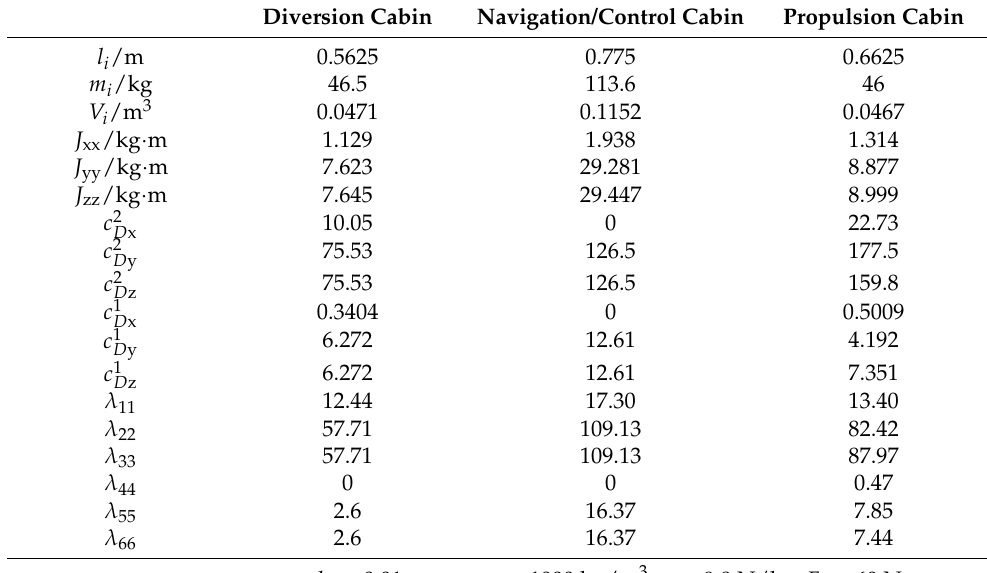
Table A1. The Parameters of the MJ-AUV